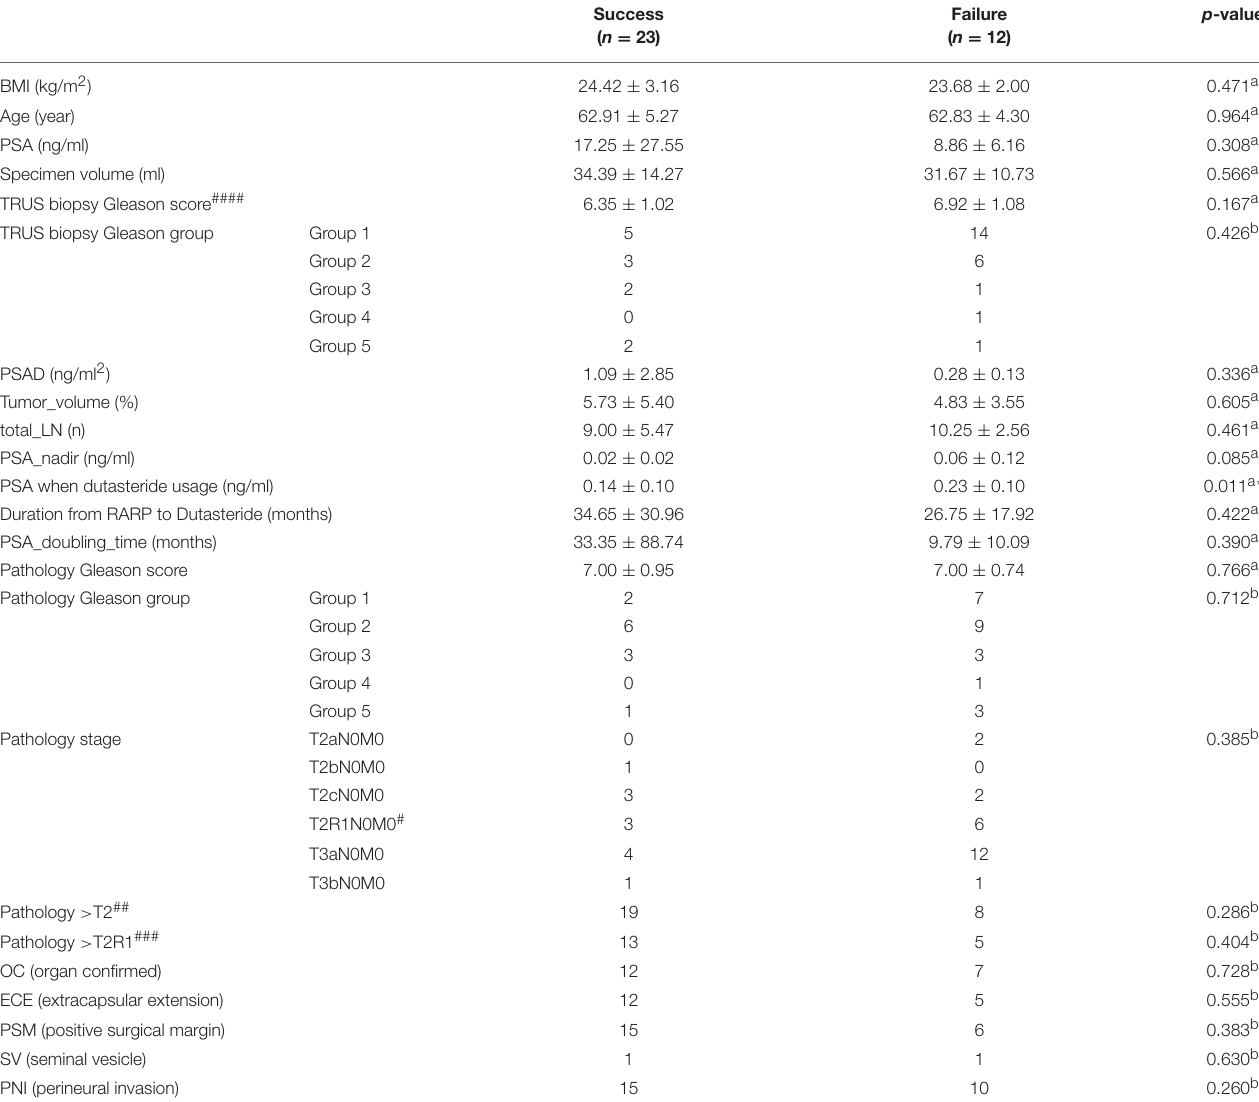
TABLE 4 | Comparison of clinicopathological variables between success and